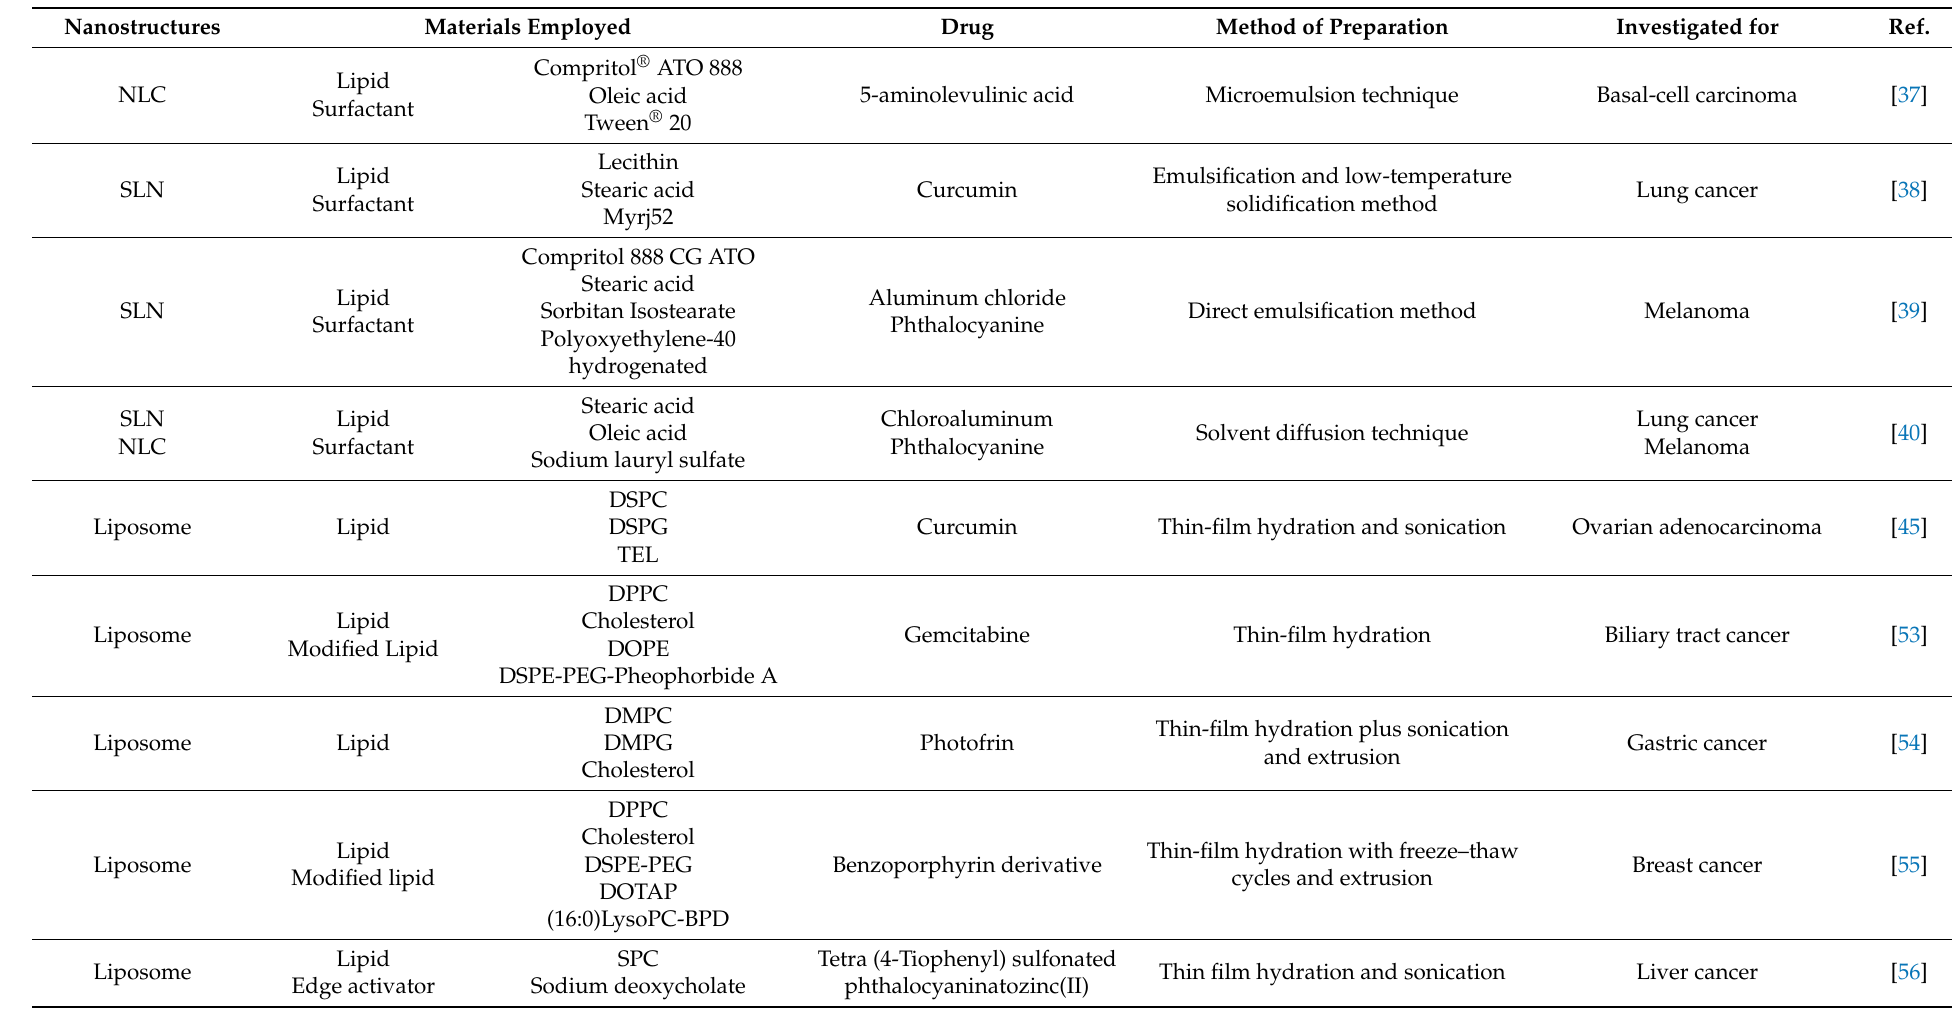
Table 1. Brief description of some organic nanostructures cited in this review as well as their materials, methods of preparation and type of cancer used to test the potential photodynamic therapy of the